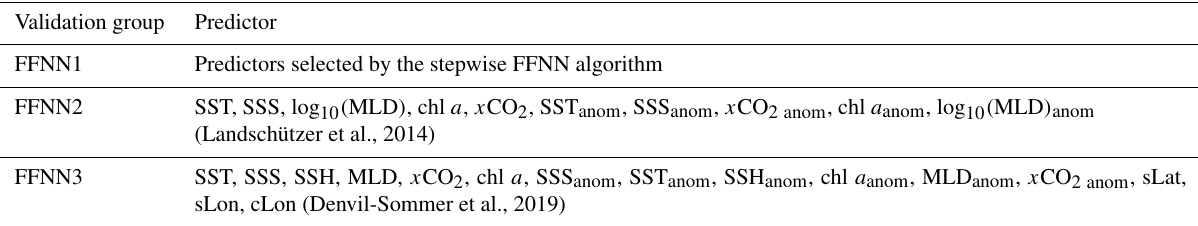
Table 2. Validation group using different predictors.